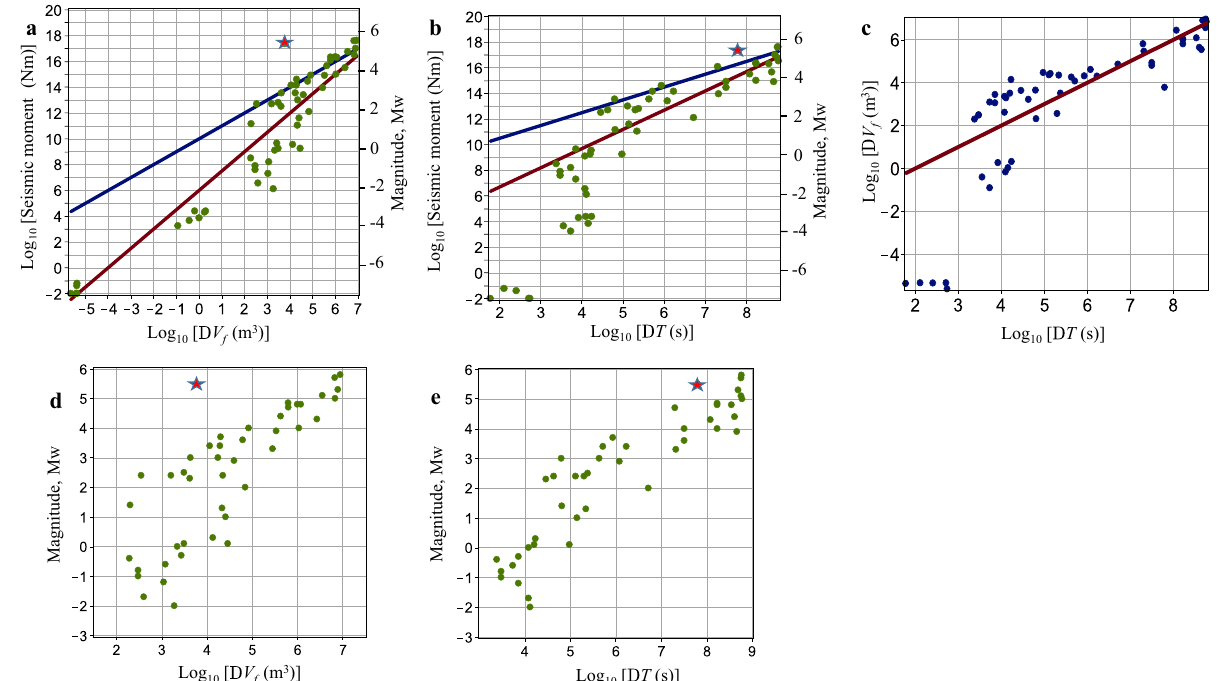
Fig. 1 M max observations (green points) in fl uid-injection environments. M max vs. a injected fl uid volume Δ V f and b elapsed time Δ T from the beginning of fl uid injection until M occurs. The data include fi eld observations of seismicity induced by injections in deep boreholes 5 – 7,12, 18, 2431 – 56 (data points with max Mw > − 3), and observations obtained from mine (underground laboratory) and laboratory experiments on small samples 57,58 (data points with Mw < − 3). The straight lines correspond to scaling laws L ∝ Δ T ξ with ξ = 1/2 (red line; normal-diffusion growth) and ξ = 1/3 (blue line; it yields a proportionality of the seismic moment to Δ V f ). The Mw5.5 Pohang earthquake 18, 19 is shown by the red stars. c Δ T versus Δ V f (the x - and y coordinates of the blue points) for the data in a , b ; the red line shows a proportionality. d , e The same as in a , b but the plots have equal x - and y axes ranges, respectively, and include only the fi eld observations of injections in deep